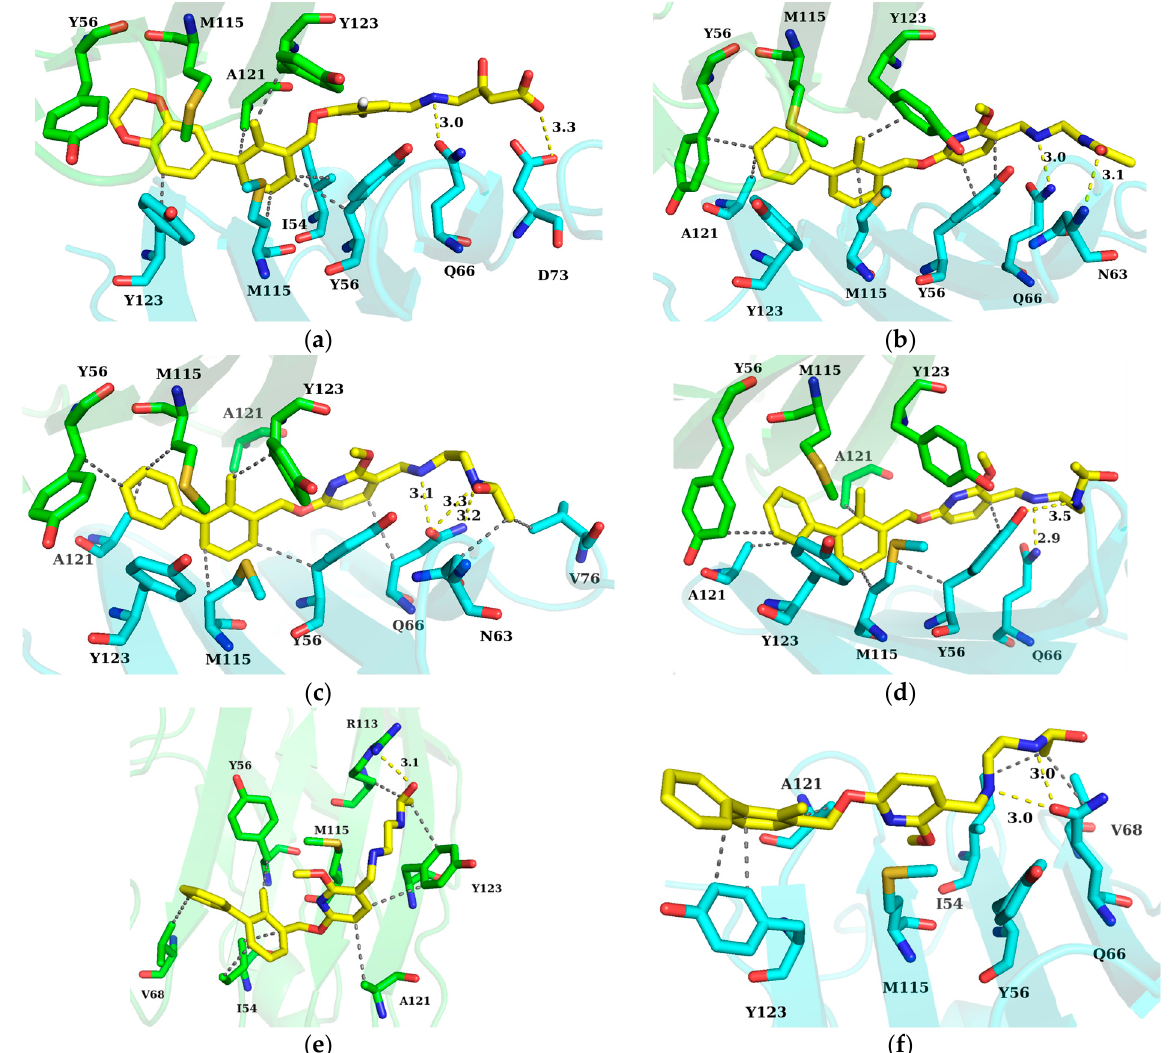
Figure 7. Interaction pattern of each system. ( a ) BMS-200 system. ( b ) BMS-202 system. ( c ) MS system. ( d ) MR system. ( e ) SA system. ( f ) SB system. The A PD-L1 and B PD-L1 are colored in green and cyan, respectively, while small molecule inhibitors are colored in yellow. Hydrogen bonds and non-polar interaction are shown as yellow and gray dotted lines, respectively.